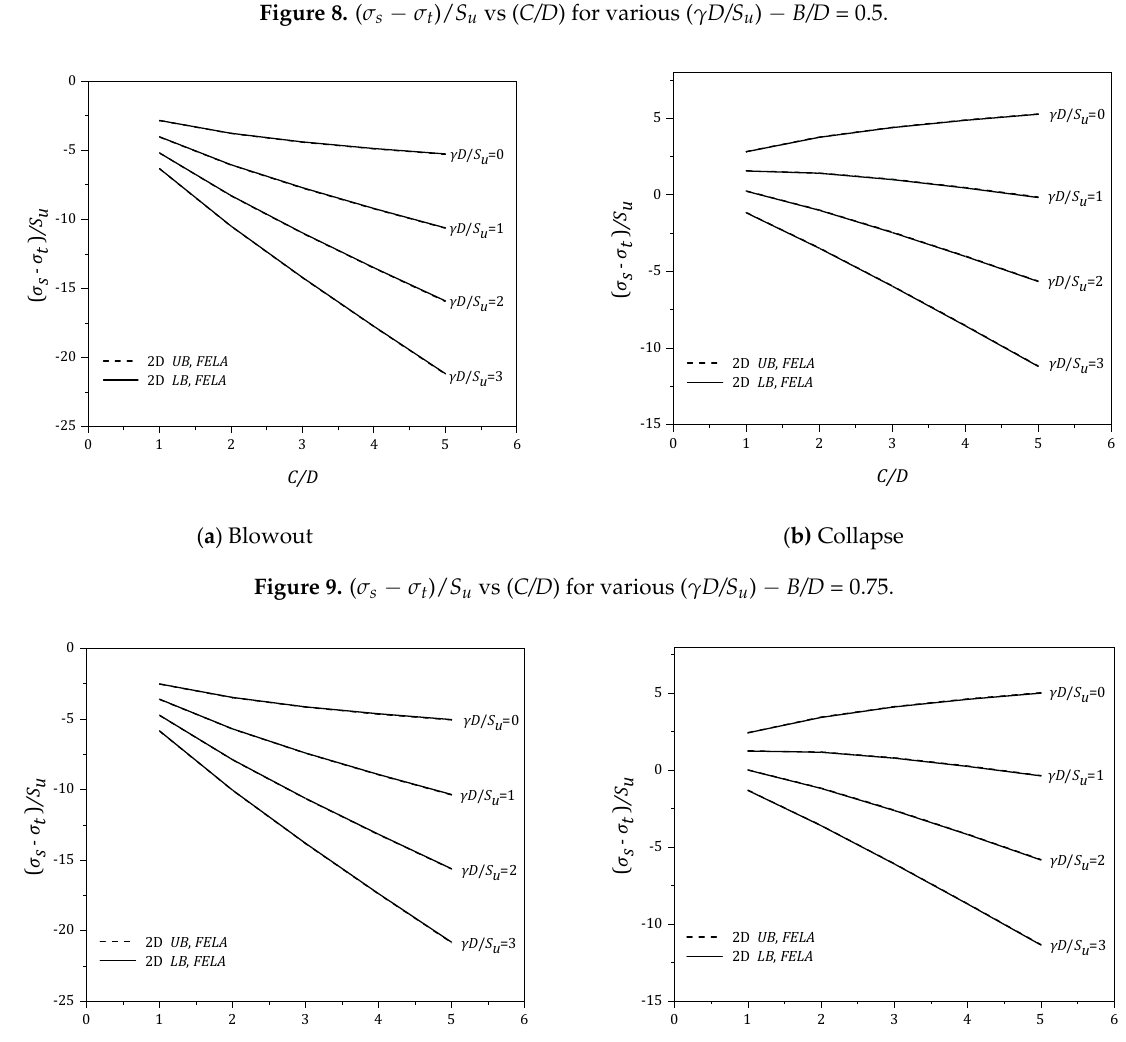
Figure 10. ( σ s − σ t )/ S u vs ( C/D ) for various ( γ D/S u ) − B/D = 1.